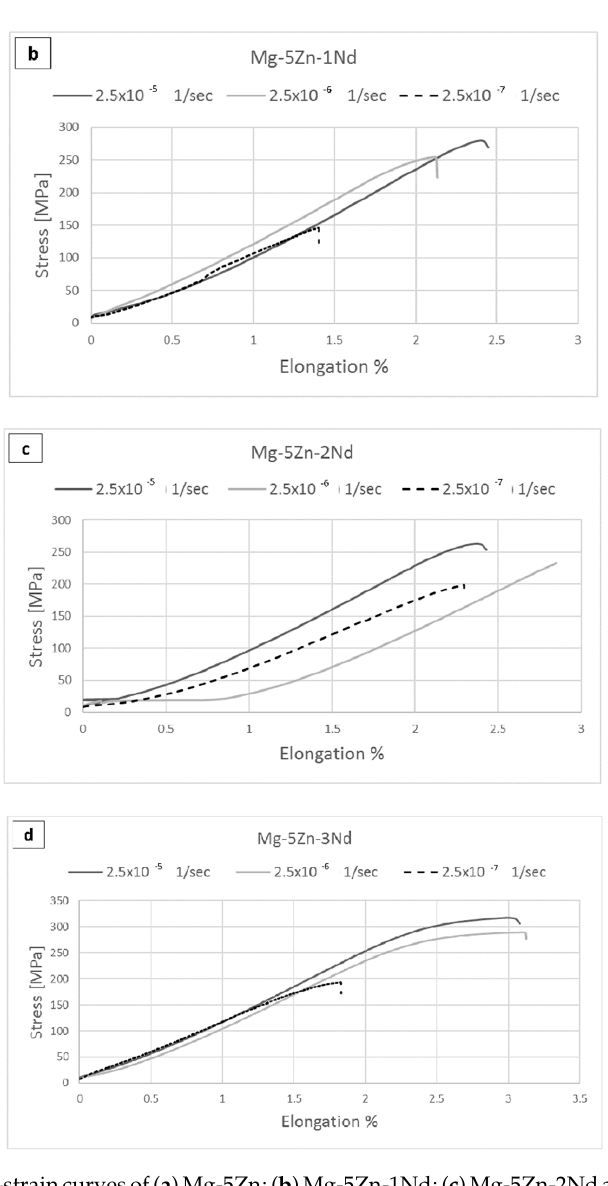
Figure 2. The stress–strain curves of ( a ) Mg-5Zn; ( b ) Mg-5Zn-1Nd; ( c ) Mg-5Zn-2Nd and ( d ) Mg-5Zn- Figure2. Thestress–straincurvesof( a )Mg-5Zn; ( b )Mg-5Zn-1Nd; ( c )Mg-5Zn-2Ndand( d )Mg-5Zn-3Nd 3Nd at various strain rates in phosphate-buffered saline (PBS); slow strain rate testing (SSRT) obtained at various strain rates in phosphate-bu ff ered saline (PBS); slow strain rate testing (SSRT) obtained by by the SSRT analysis. the SSRT analysis. Metals 2020 , 10 , x FOR PEER REVIEW